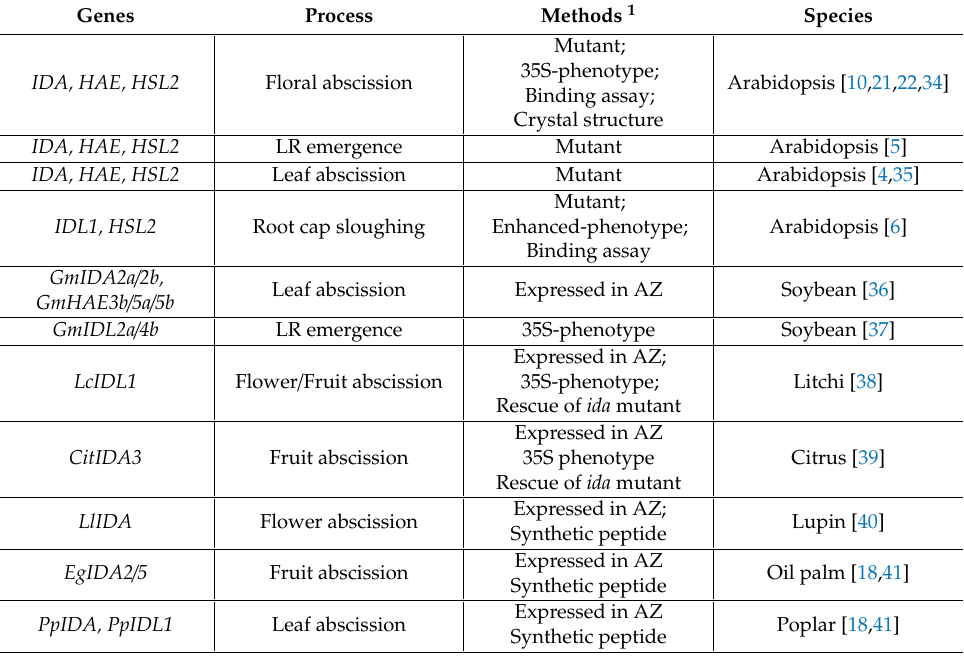
Table 1. Overview of IDA / IDLs during abscission and other cell separation processes in